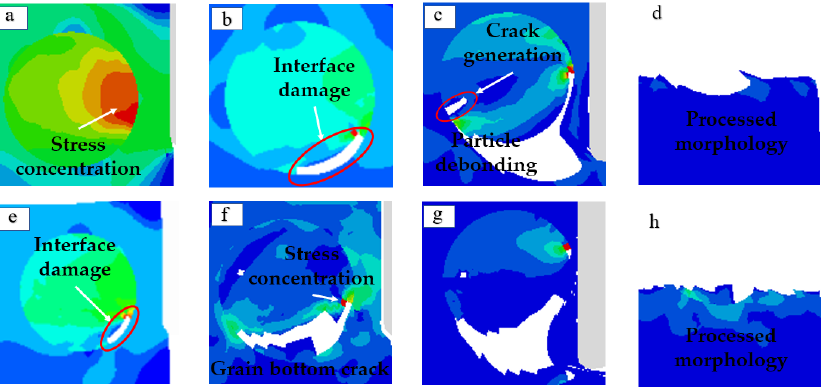
Figure 8. Simulation of TiC particle 1 failure removal process. ( a – d ) CCT. ( e – h ) UCT. Different colors represent the stress distribution, the brighter the color the more intense the stress concentration.